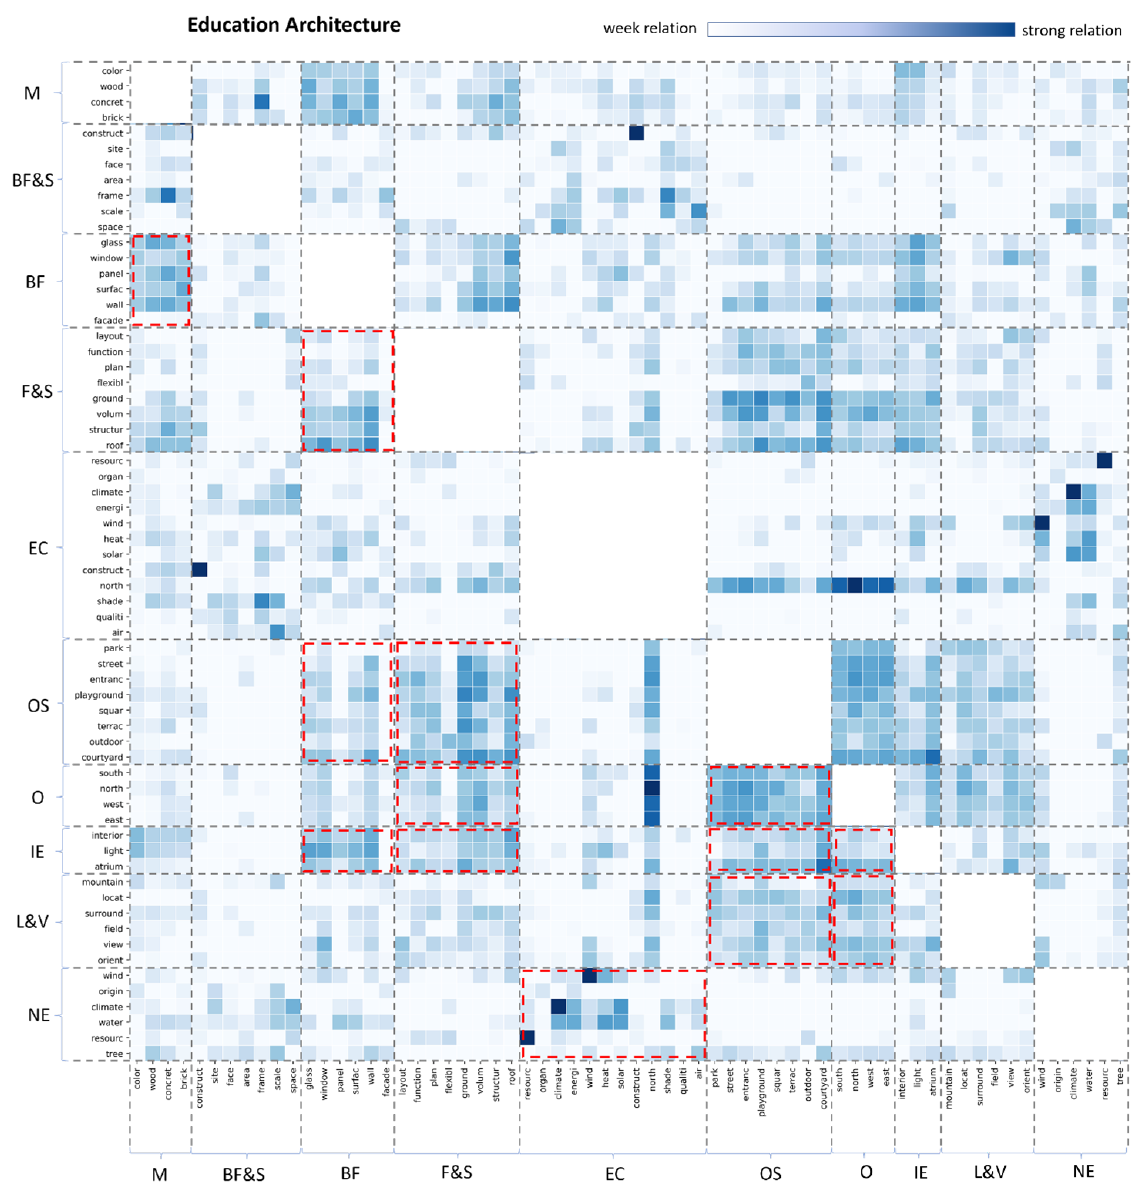
Figure 9. Heat map of clustered words related to education architecture. For commercial architecture, the correlations between the clustered words and design elements were quite different. Site layout (SL), energy consumption (EC) and natural environment (NE) had no obvious connections with the other elements. However, the other eight design elements had stronger and more obvious connections with each other those for the other building types, as visualized in Figure 10. These eight design elements had close relationships with at least three elements. Interior environment (IE) and building façade (BF) both had relationships with seven elements and the correlation between these two elements was stronger than